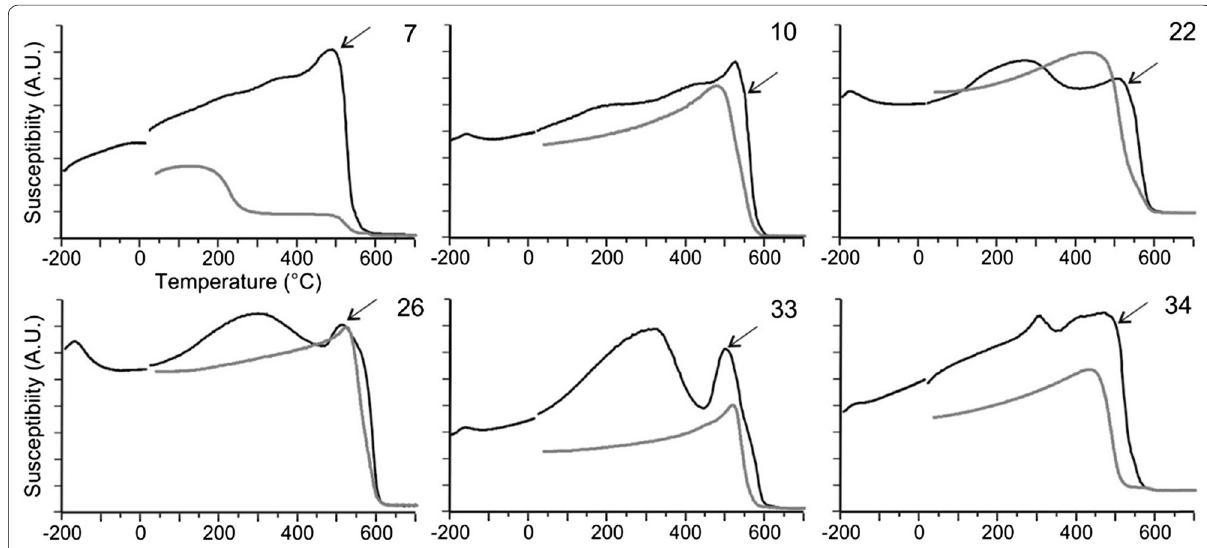
Fig. 2 Representative χ‑T curves of the basalts showing the variation in magnetic susceptibility during heating (black) and cooling (gray). The higher T C is marked by a black arrow. AU arbitrary units